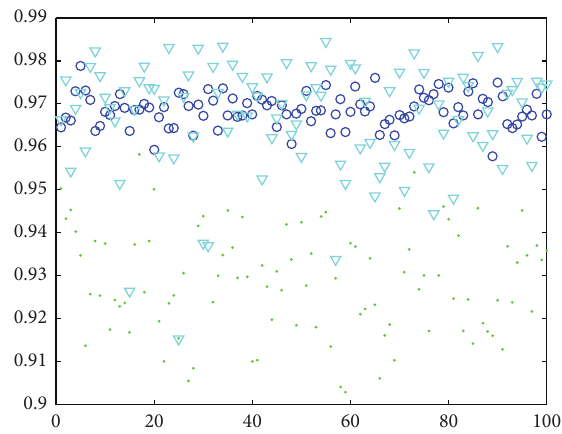
Figure 2: Spectral radius of random PSD matrices 𝐴 𝑇 𝐴 + 10 ∗ diag ( rand (𝑛, 1)) with nearly half of the entries of 𝐴 negative and 𝑛 = 50